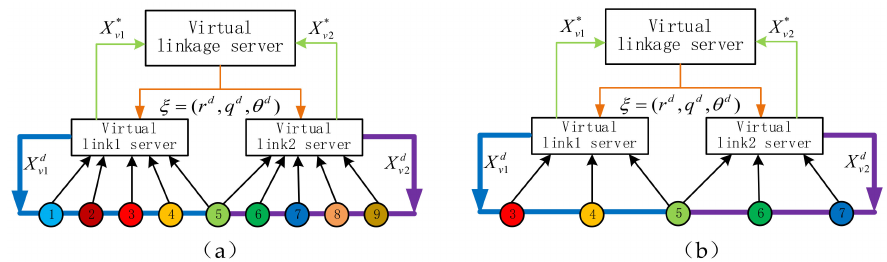
Figure 21. Comparison between virtual linkages with different number of agents: ( a ) the virtual linkage defined in Equation (11); ( b ) the virtual linkage defined in Equation (16).